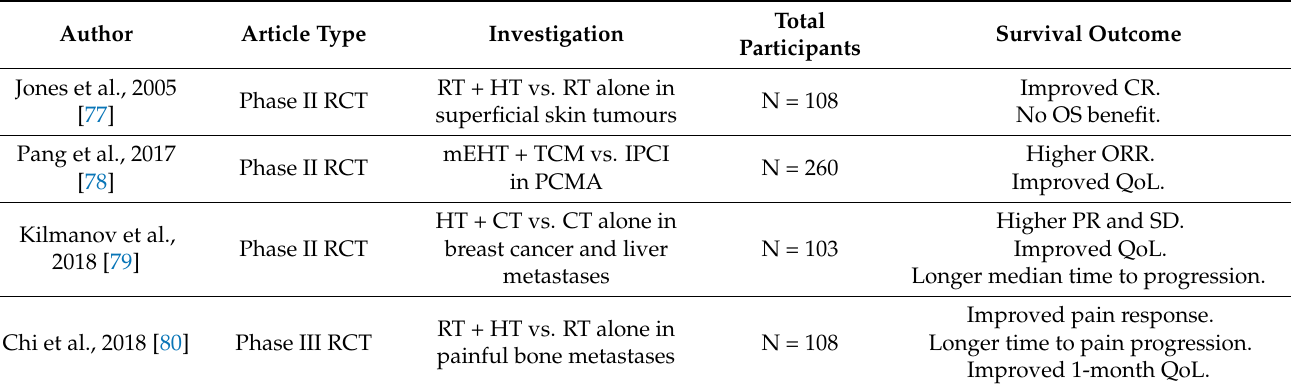
Table 6. HT for patients with palliation. Summary of articles